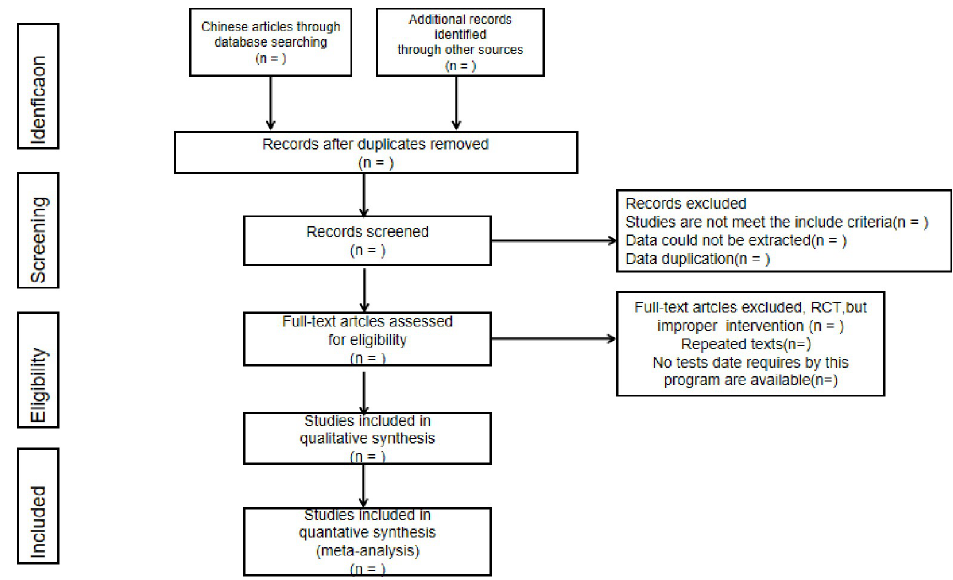
Fig 1. Flow chart of the study. Adapted from Preferred Reporting Items for Systematic Reviews and Meta-Analyses Protocols (PRISMA-P). RCT = Randomized controlled trial.